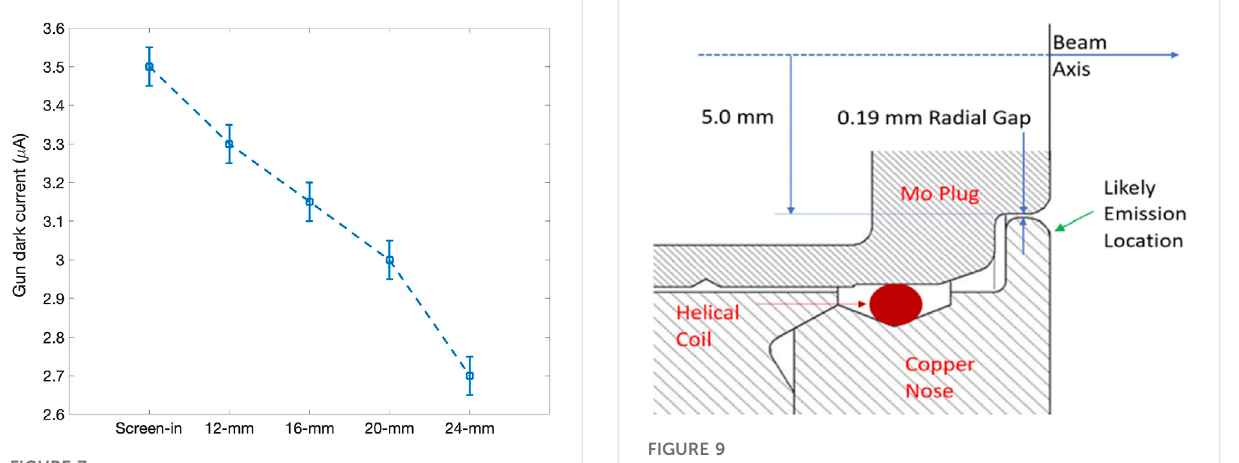
FIGURE 7 Dark current measured 1.5 m from the cathode with different LEB collimator sizes. For the ‘ Screen-In ’ case, a thin YAG screen intercepts the full current.